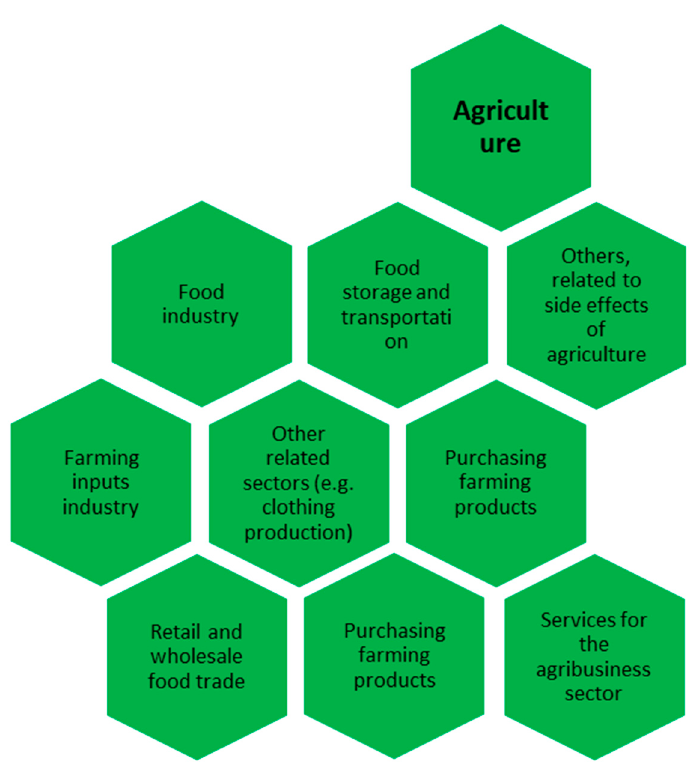
Figure 1. Areas generating labour demand in agribusiness. Source: own study.